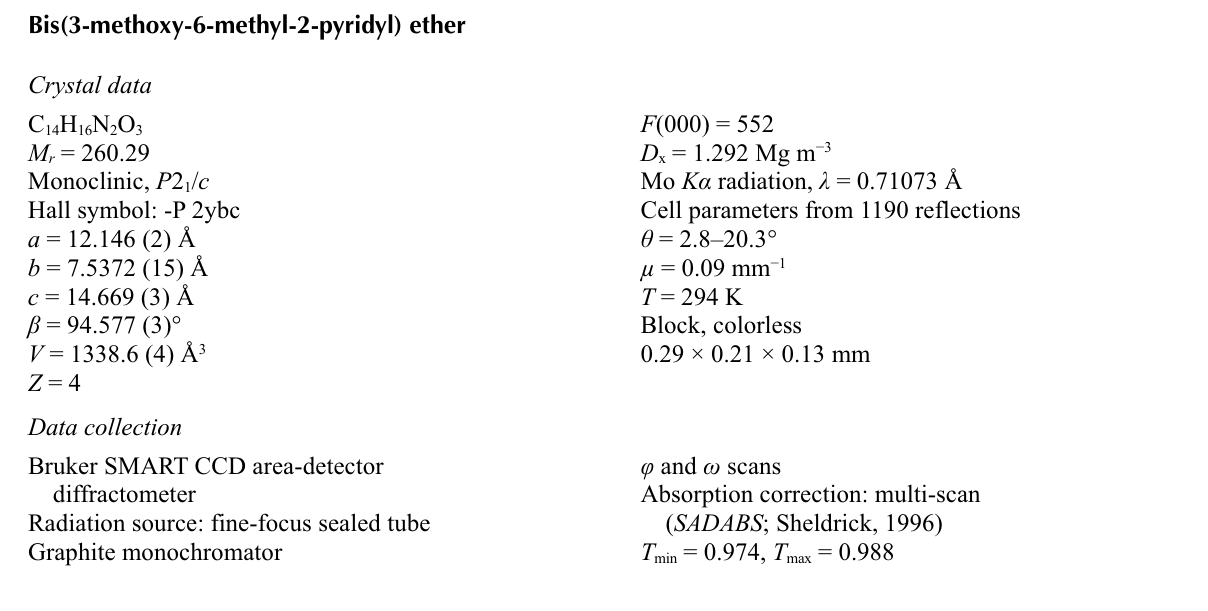
A packing diagram of (I). Hydrogen bonds are shown as dashed